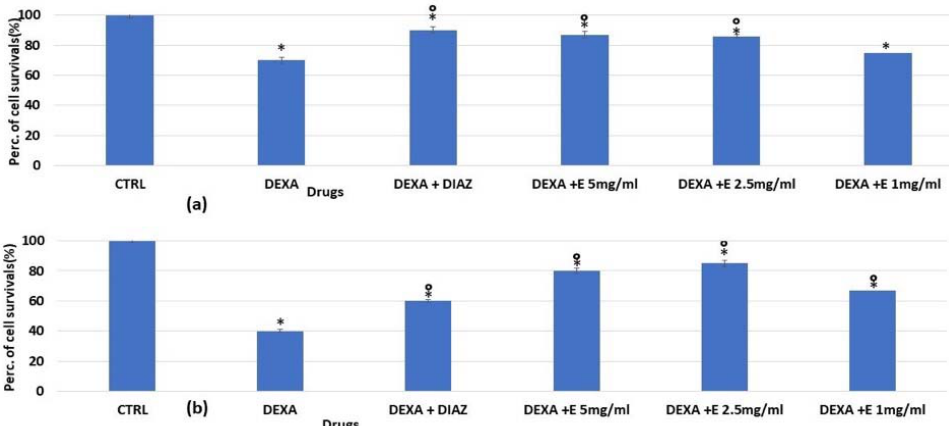
Figure 3. Percentage changes in cell growth values for osteoblasts after ( a ) 24 h and ( b ) 48 h of incubation with dexamethasone 2 × 10 − 6 M (DEXA), dexamethasone, and diazoxide (DIAZ) (250 × 10 − 6 M), and dexamethasone in the presence of a different concentration of the extract in the MTT assay. The reported values represent an average of at least six replicates. One-way analysis of variance with ANOVA was performed to determine the significance of the data vs. controls (CTRL) * or dexamethasone ◦ with a value of p < 0.05.